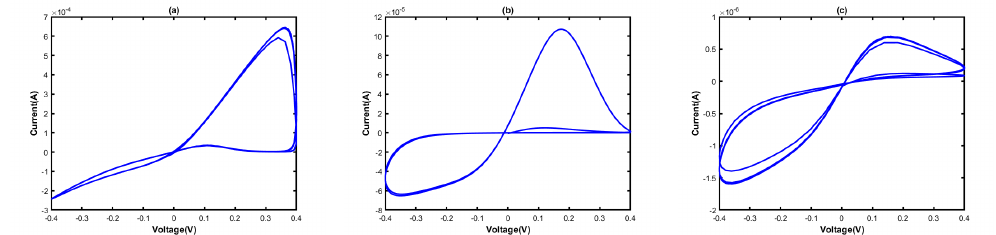
Figure 15. Pinched hysteresis loops for temperatures and process corners, for 16 nm: ( a ) − 40 ◦ C, ( b ) 27 ◦ C, and ( c ) 80 ◦ C.